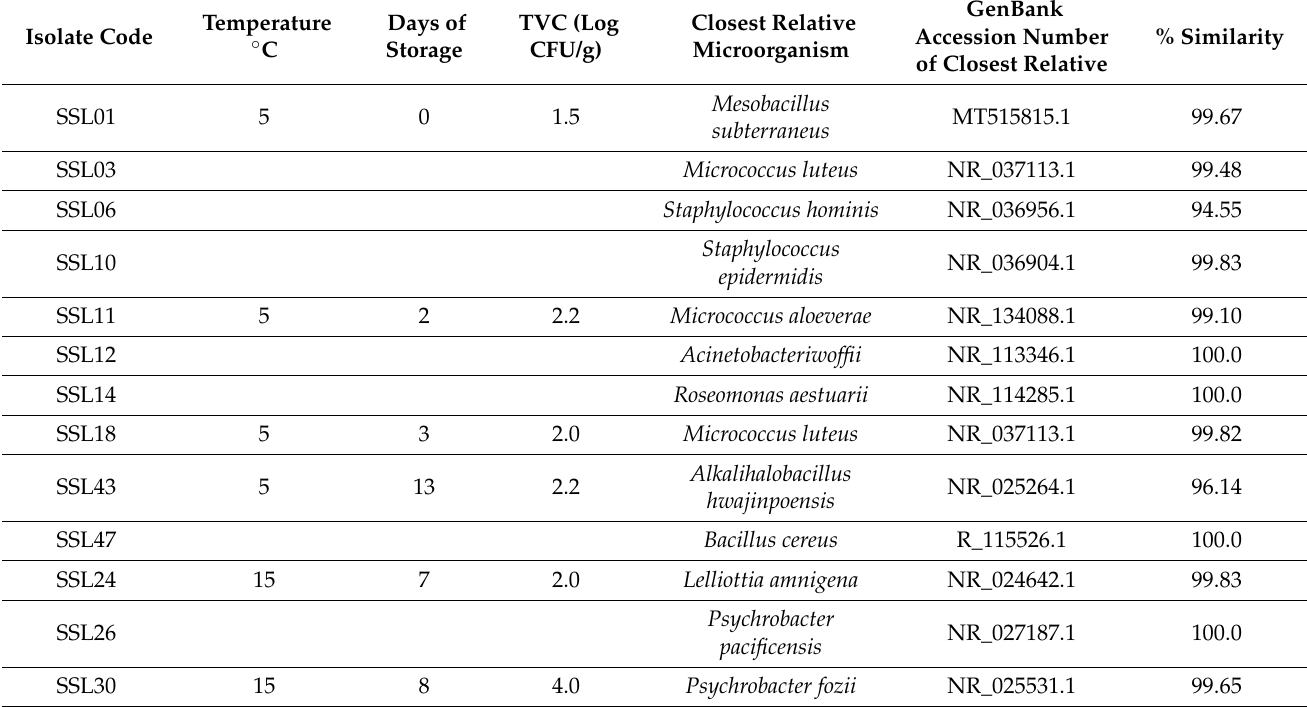
Table 4. Species identification of bacteria isolated from S. latissima